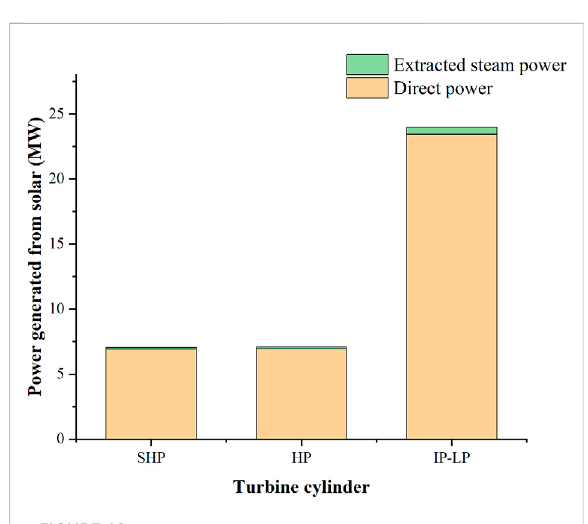
FIGURE 10 Distribution of power generated from solar in the turbine cylinder under 50% THA